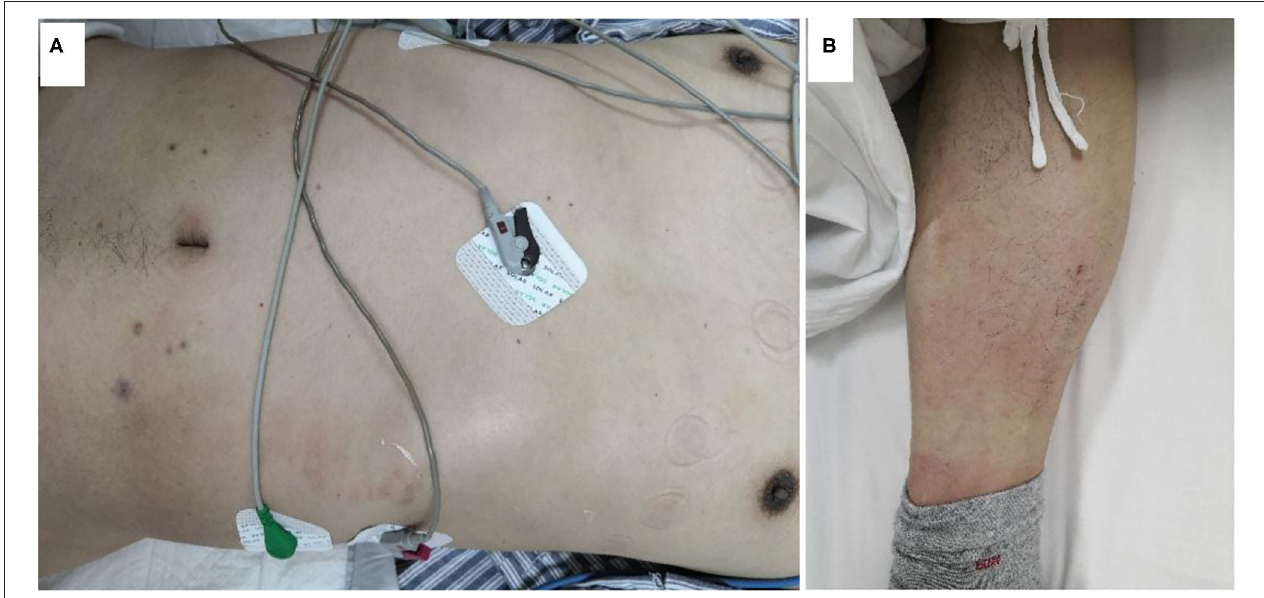
FIGURE 1 | Erythematous rash over the chest, abdomen (A) and lower limb (B)